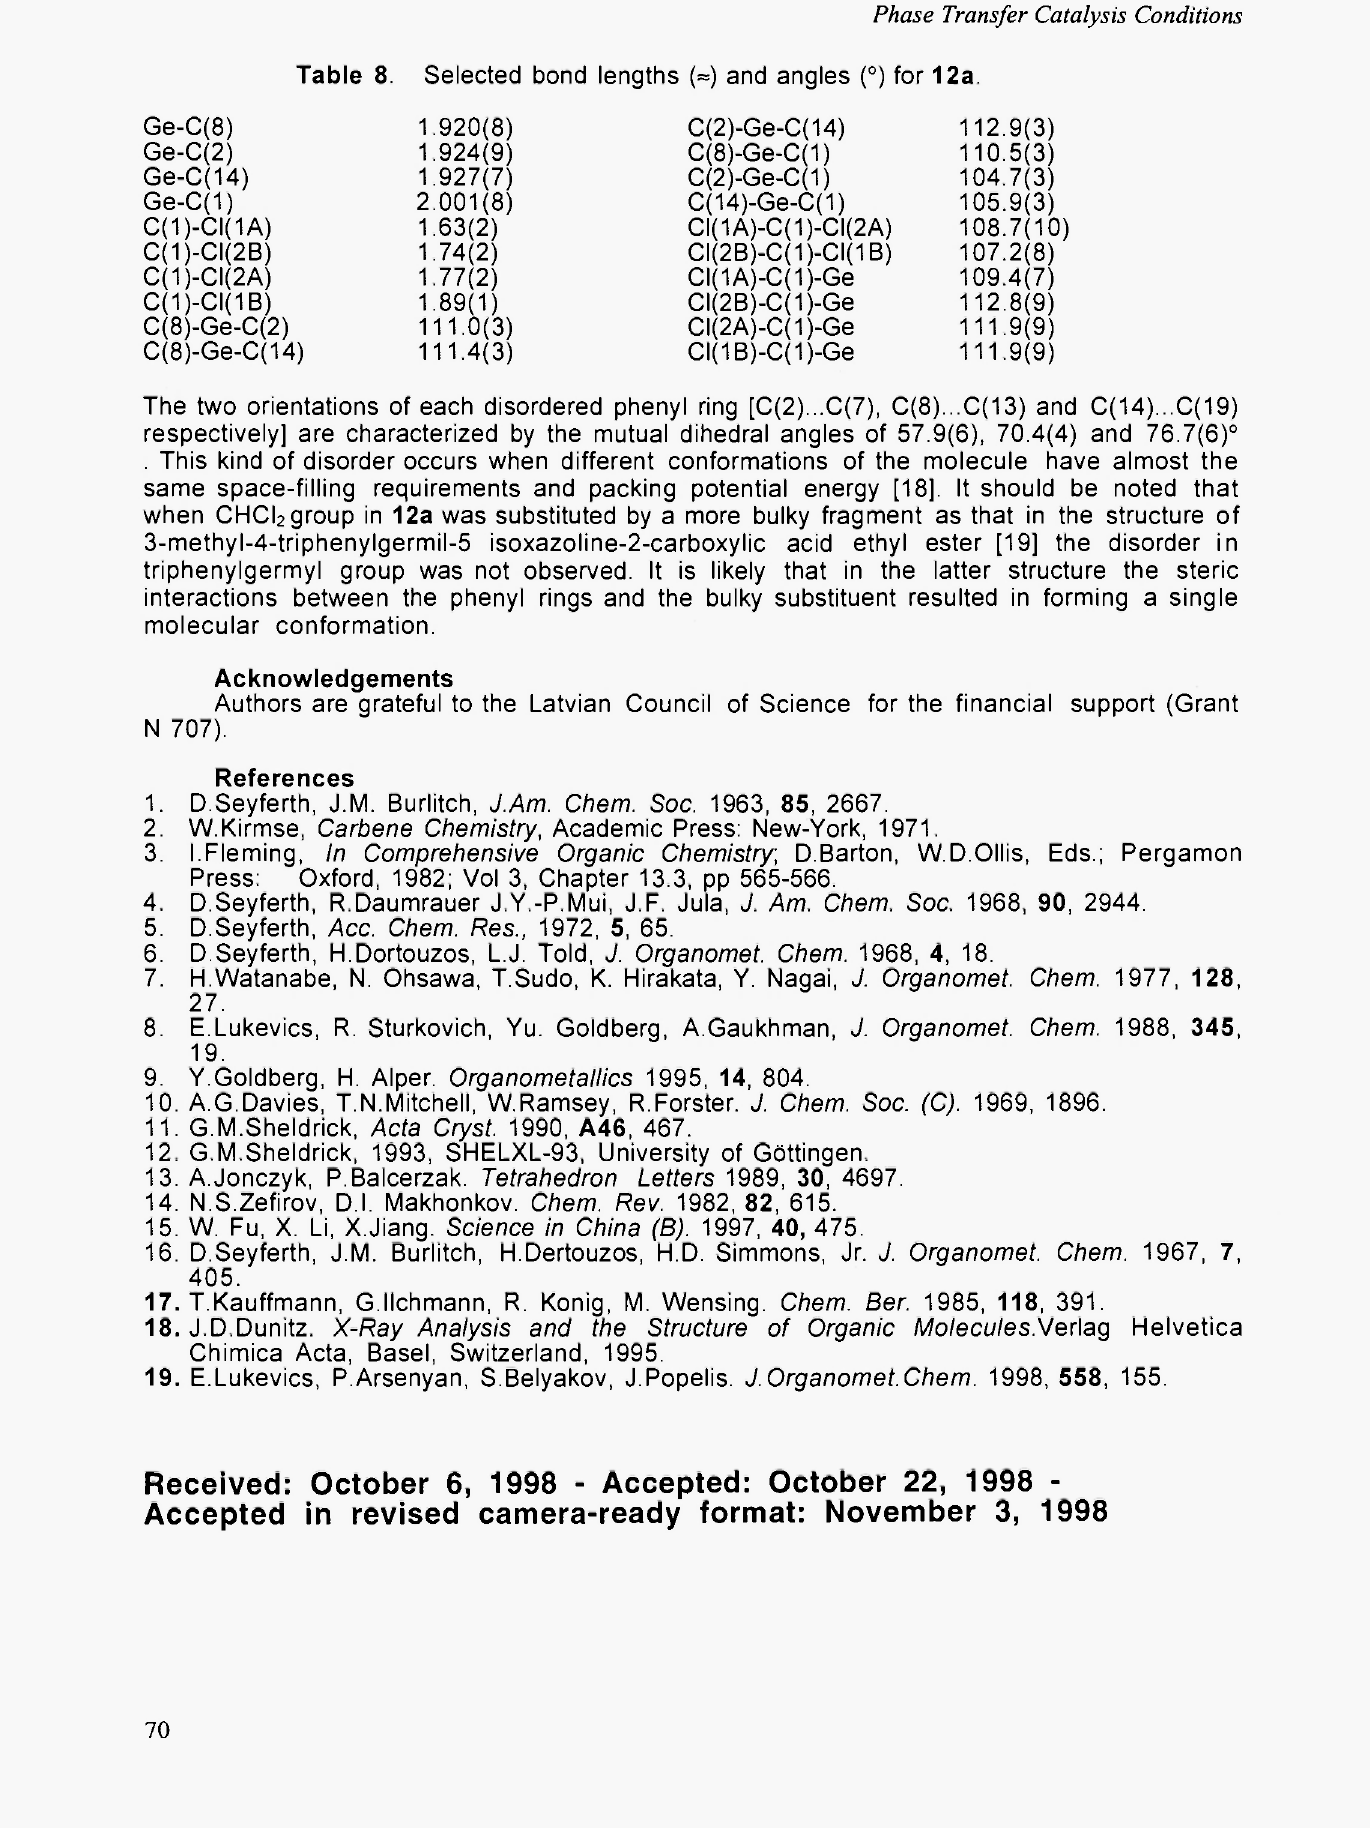
Table 8. Selected bond lengths (=) and angles (°) for